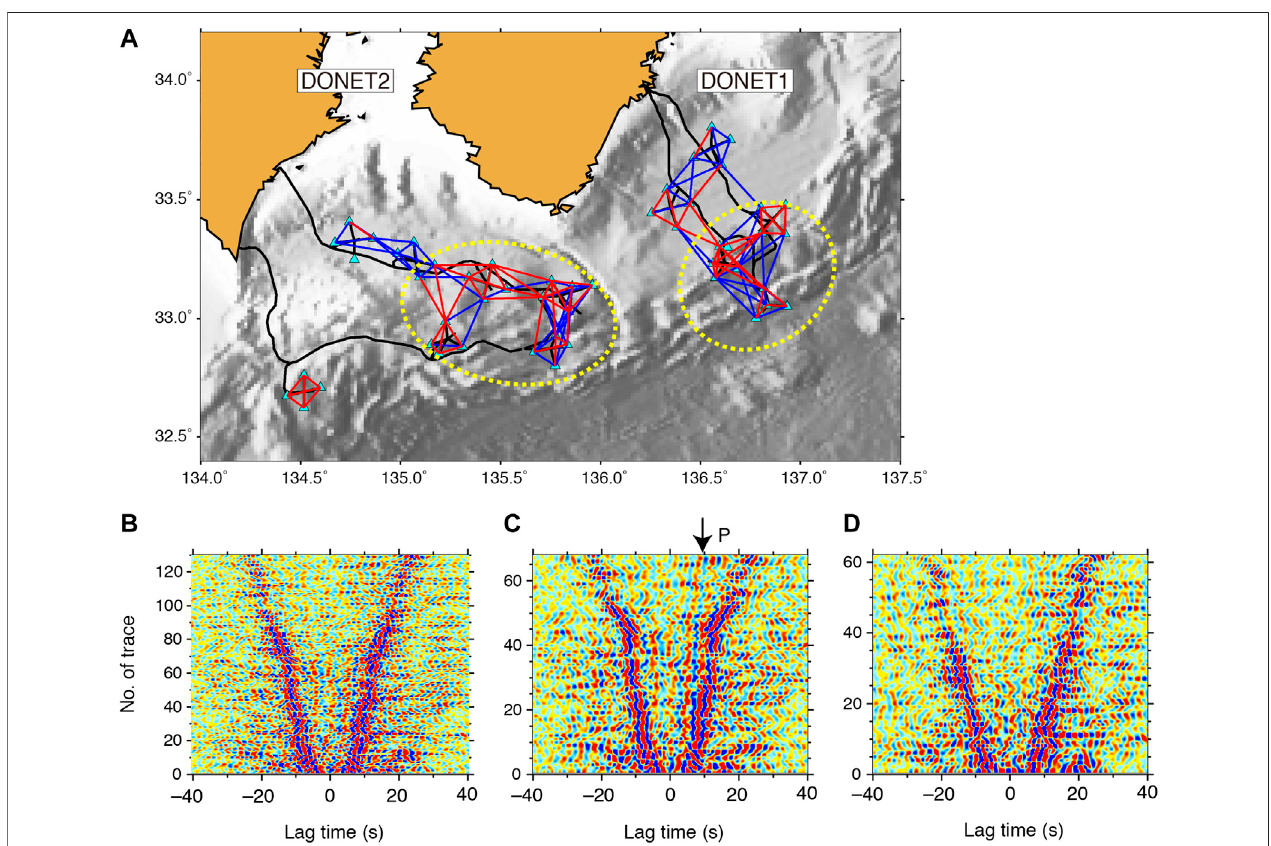
FIGURE5| ScreeningofCCFsthatshow P waveextractions. (A) Mapshowingpairsthat(redline)shows P waveextractionsandthosethat(blueline)donotshow P extractions. Dotted yellow ellipses represent theregions where P wavesareextracted. (B) P-P CCFsat 0.2 – 0.5 Hzordered byseparation distanceoftwostations (C) P-P CCFs that contain P waves are selected from CCFs in (B) . (D) P-P CCFs that do not contain P waves are selected from CCFs in (B)